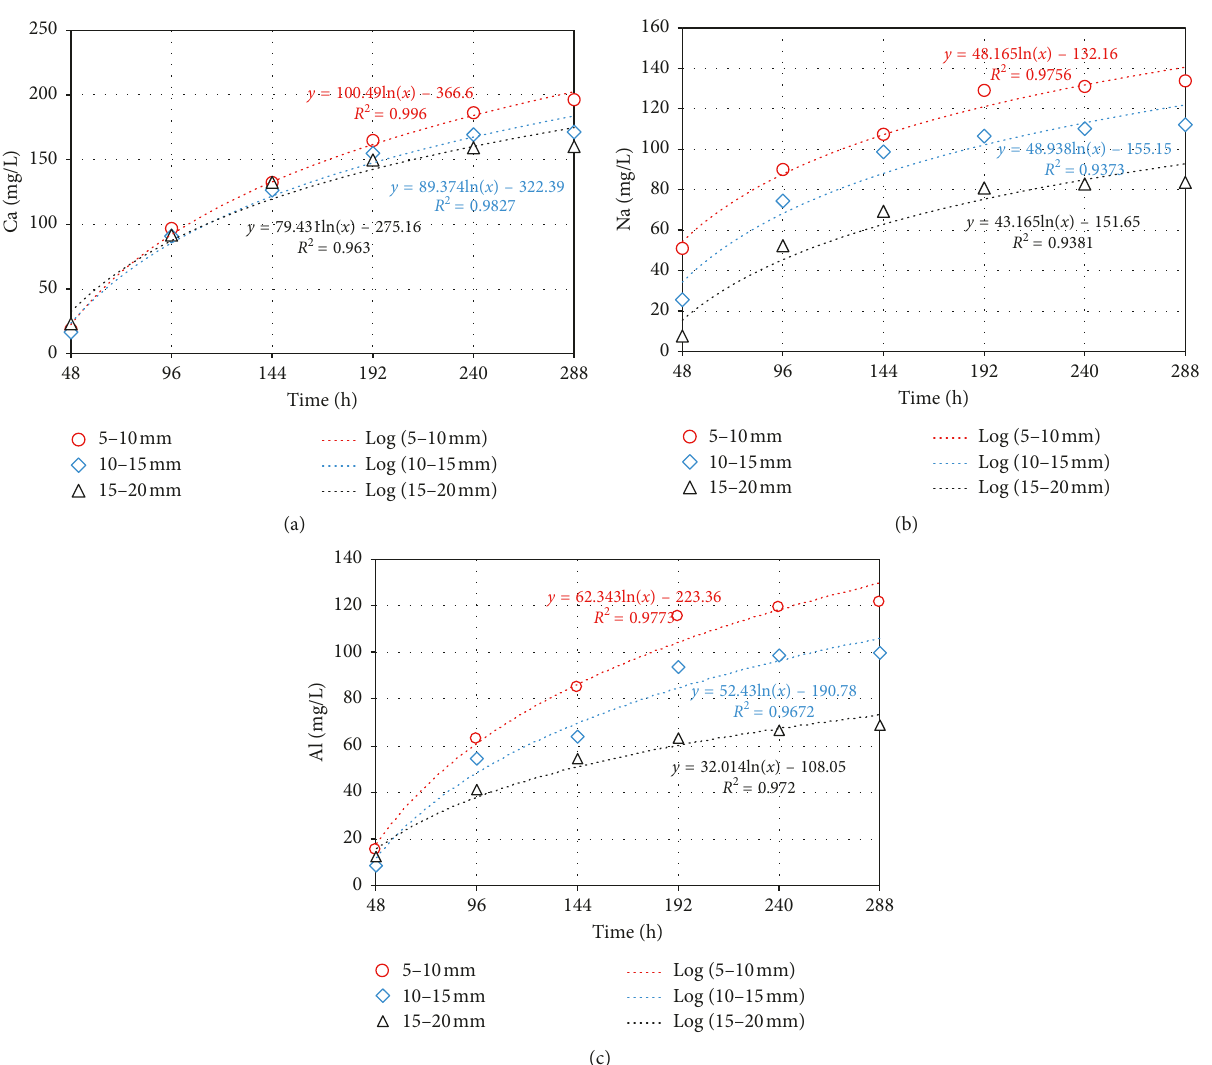
Figure 9: Ion release characteristics of gangues with different particles sizes that were immersed in pH � 3